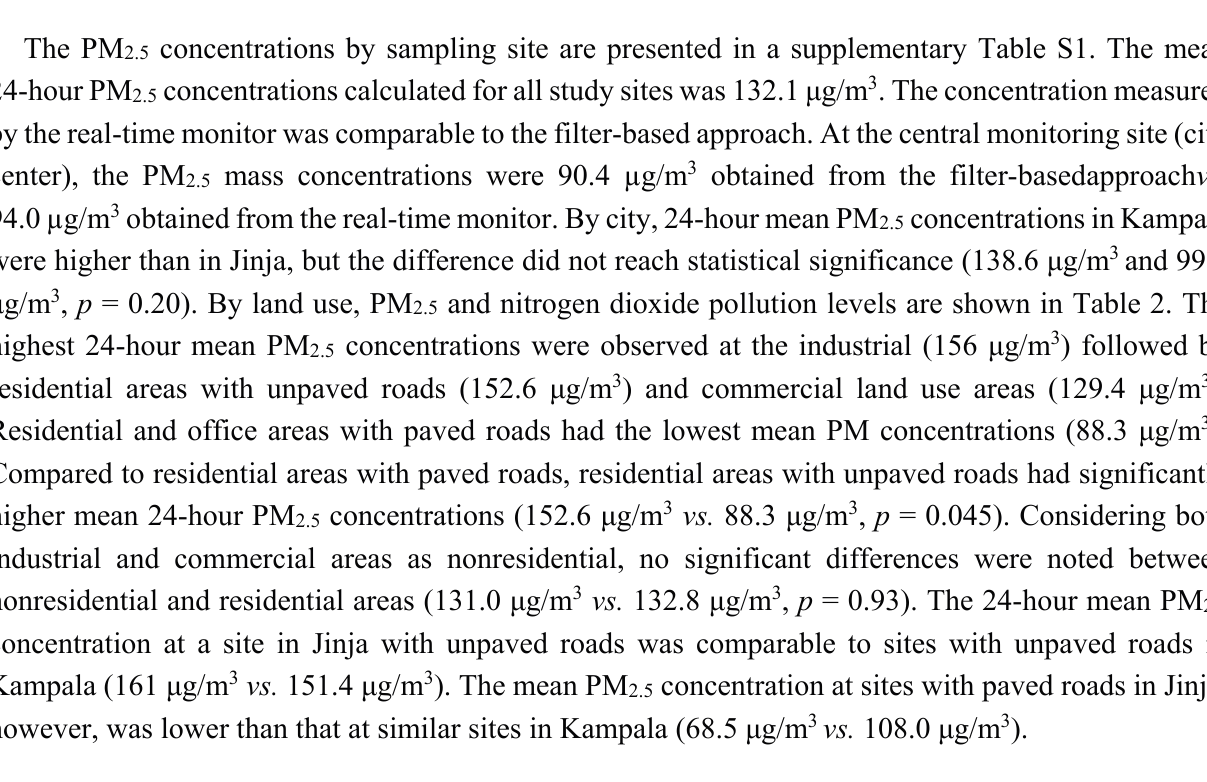
Figure 2. The spatial variation of PM 2.5 ( a ) and NO 2 ( b ) in